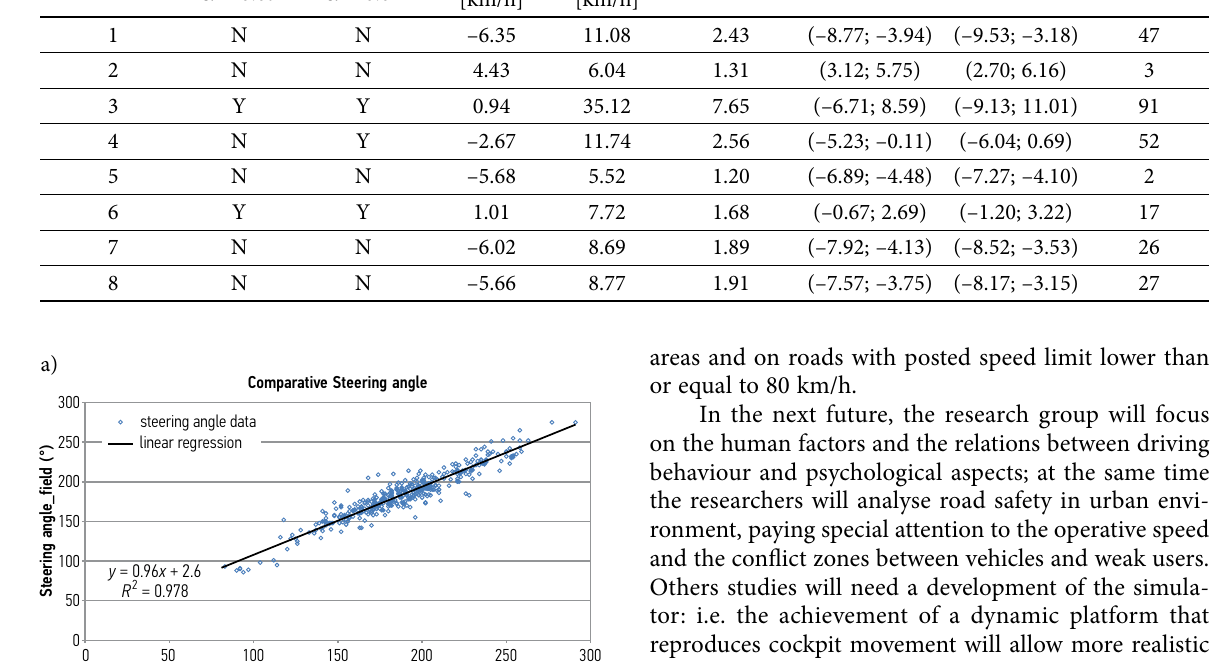
No of homogeneous